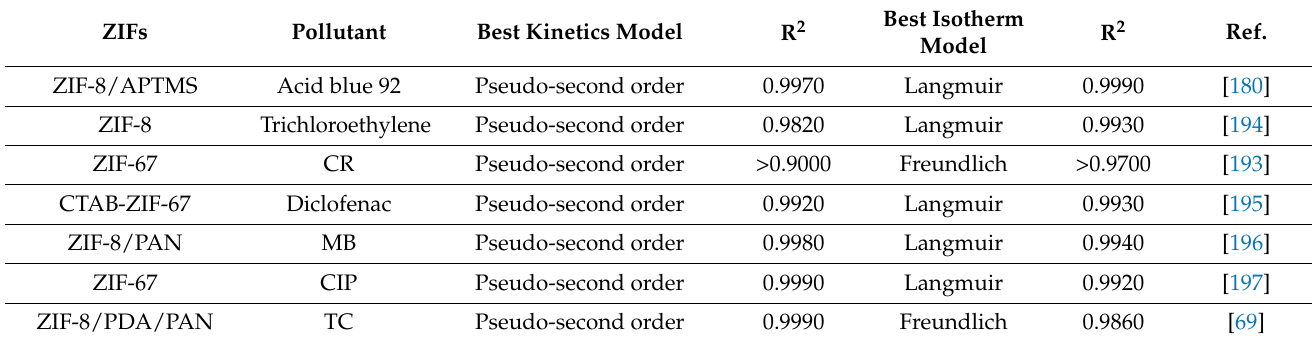
Table 3. Modeling of equilibrium isotherms and